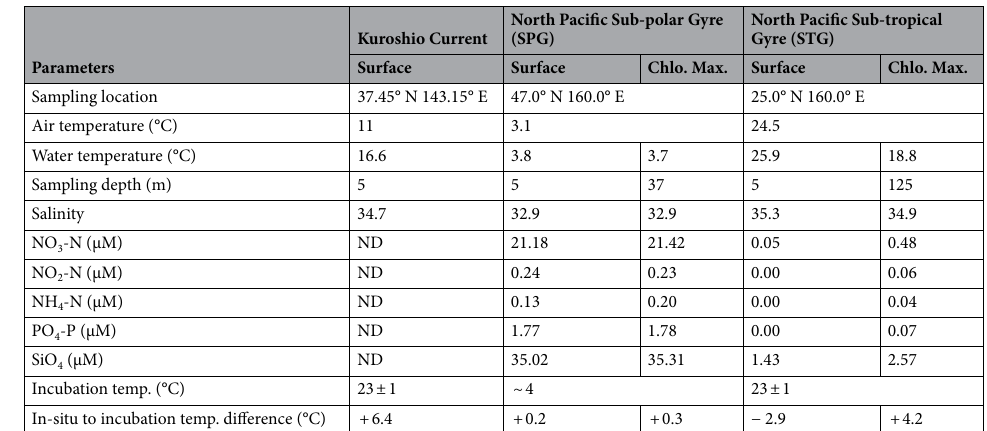
Table 1. Environmental properties of three water samples used in microcosm experiments. Microcosm experiments were conducted on board during the KH-14-2 cruise in May–June 2014. Chlo. Max. chlorophyll -a maximum, Salinity salinity indicated as practical salinity unit, ND no data.